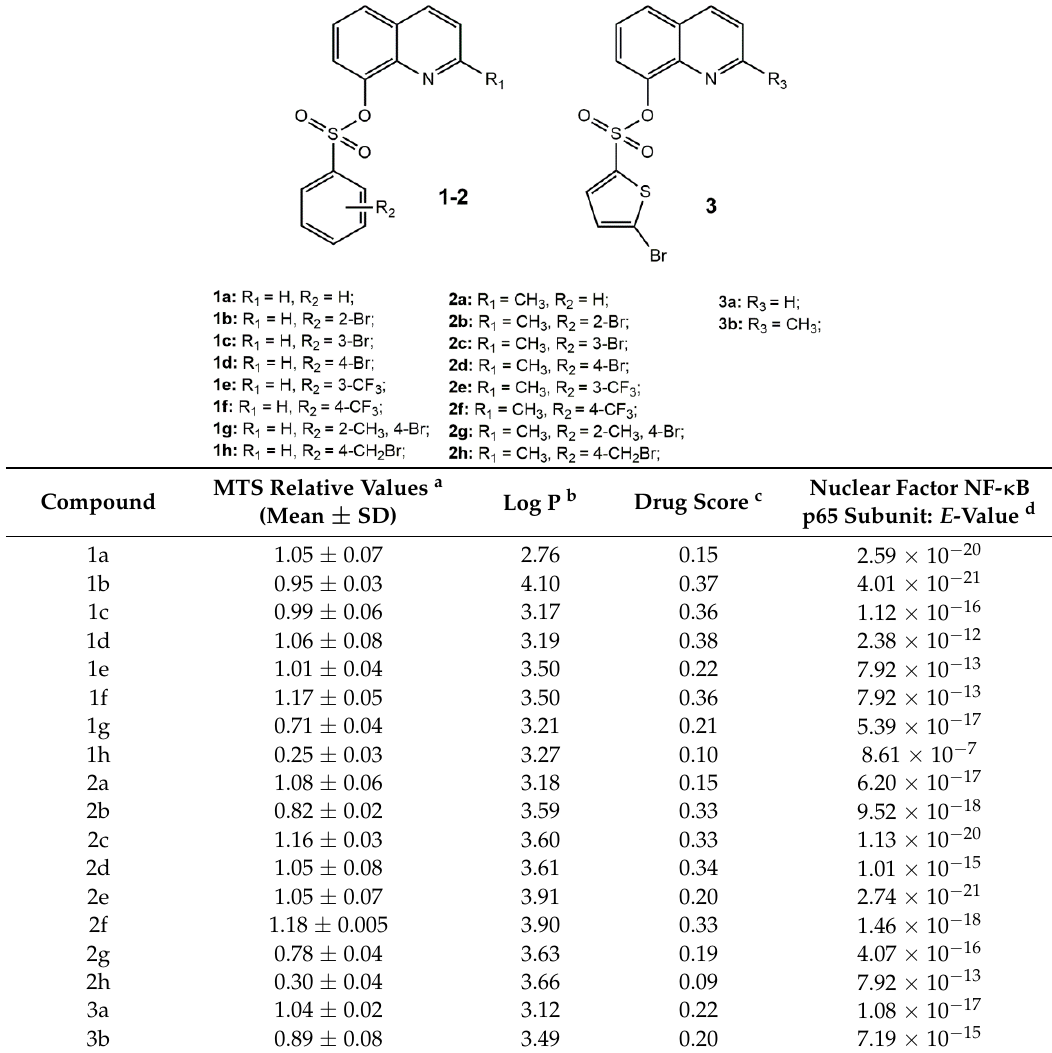
Table 1. Bioactivity of the tested compounds ( 1–3 ) against liver cancer cell line Hep3B and the related docking results.